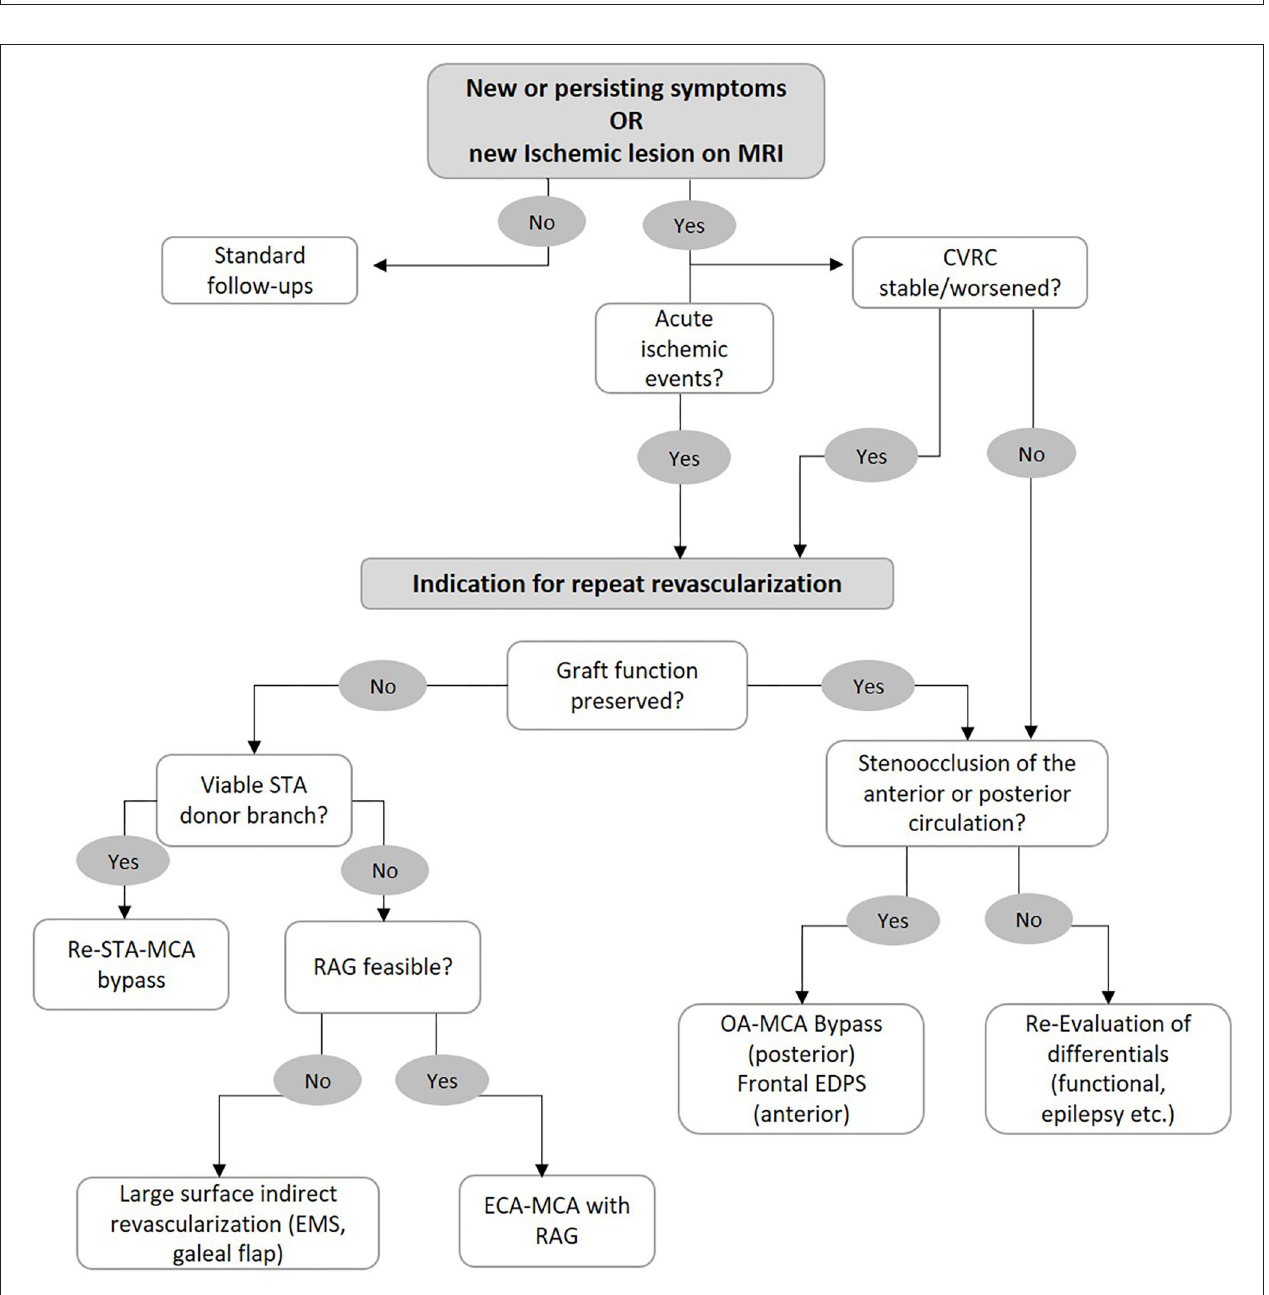
FIGURE 3 | Flowchart for selection of surgical strategy in case of bypass failure. See main text for further information.